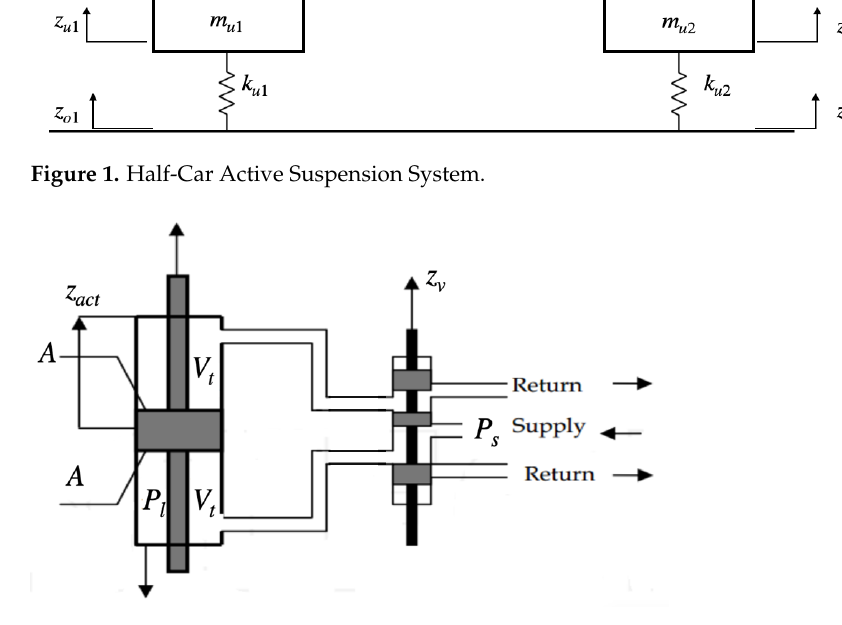
Figure 2. Electro-Hydraulic Actuator with Servo Spool